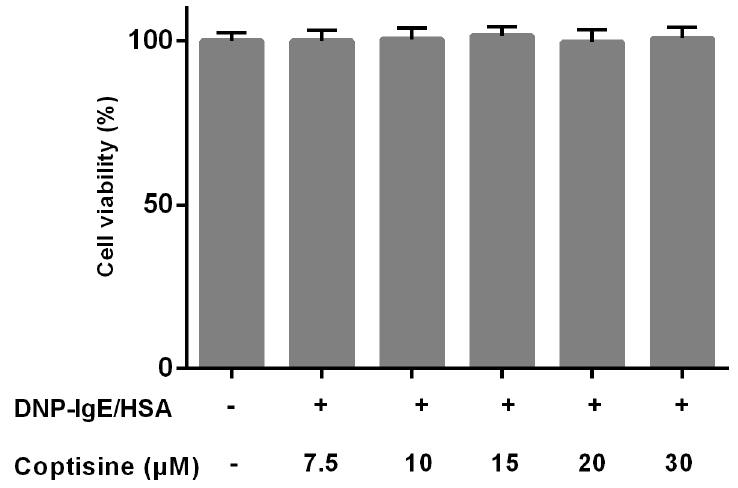
Figure 1. Effect of coptisine on the viability of RBL-2H3 cells. All data were expressed as the mean ± SE.